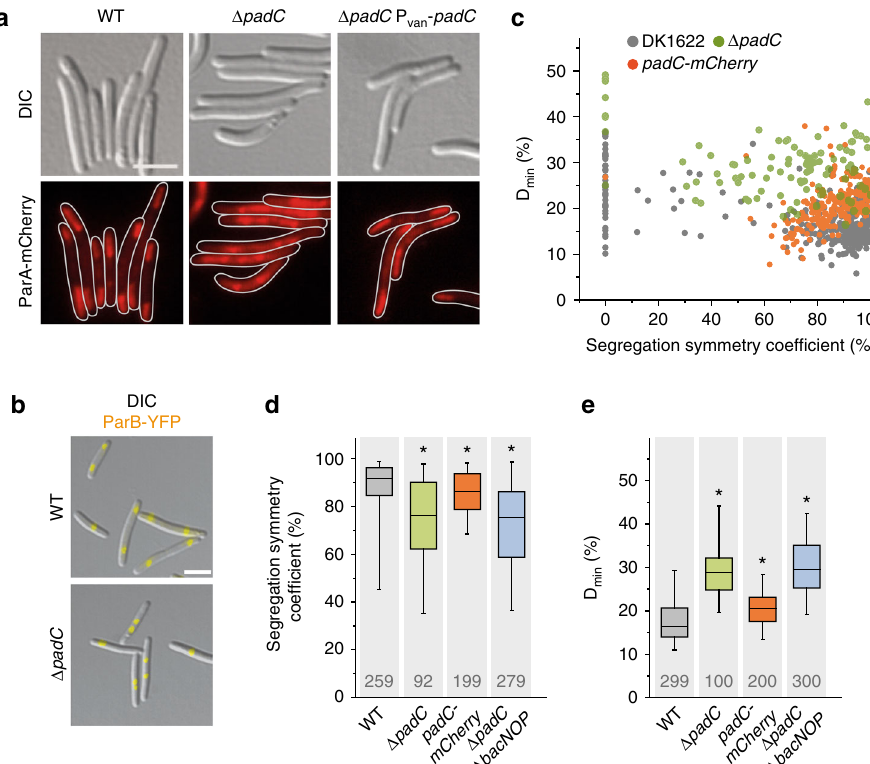
Fig. 4 PadC is required for the subpolar localization of ParA and ParB. a Mislocalization of ParA in the absence of PadC. Cells of strains of LL145 (P parA - parA-mCherry ), LL154 ( Δ padC P parA - parA-mCherry ) and LL192 ( Δ padC P parA − parA − mCherry P van − padC ) were analyzed by DIC and fl uorescence